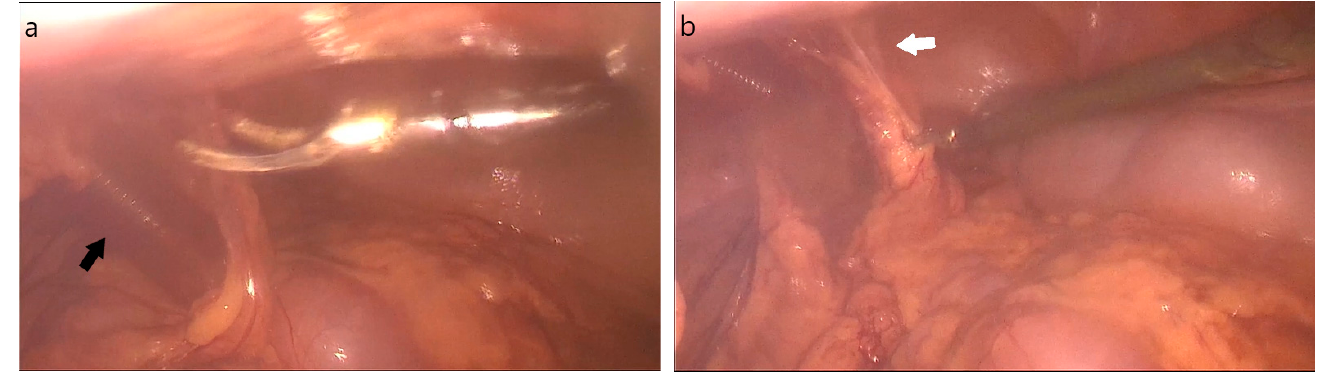
Figure 4. Adhesiolysis (white arrow in ( b ) showing adhesions) near the sub-umbilical trocar (black arrow in ( a )), that possibly led to bladder perforation either by mechanical trauma or via an electro- thermal injury. The bladder injury was not noticed